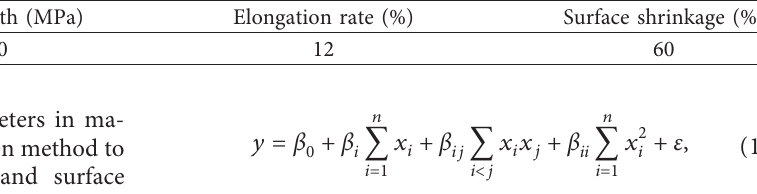
Table 2: Mechanical properties of AF1410